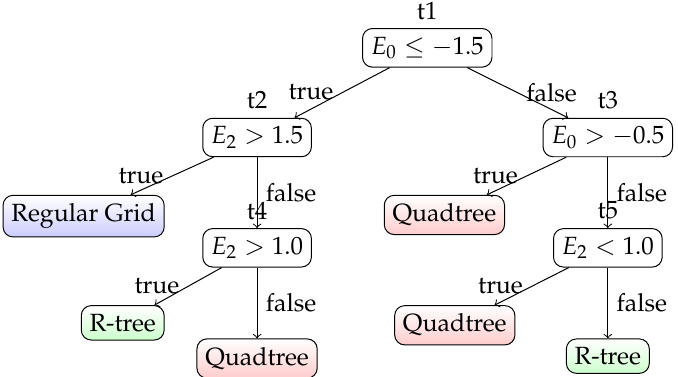
Figure 2. Decision tree for the choice of the more appropriate partitioning technique for a dataset D